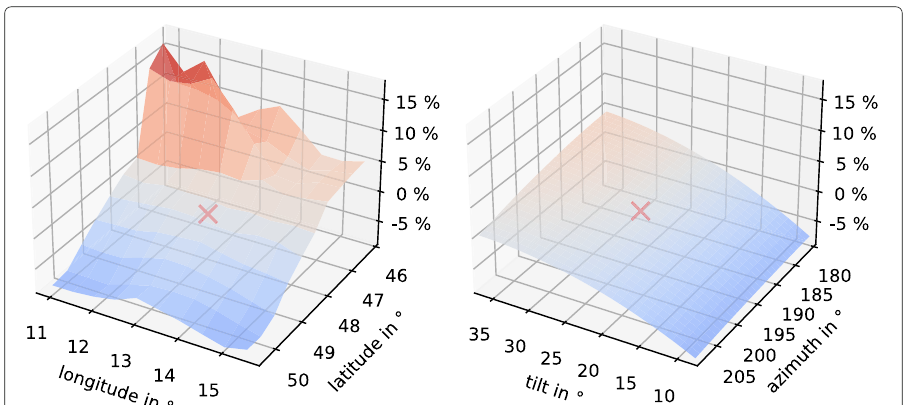
Fig. 7 Impact of azimuth and tilt error on yearly energy generation compared to actual